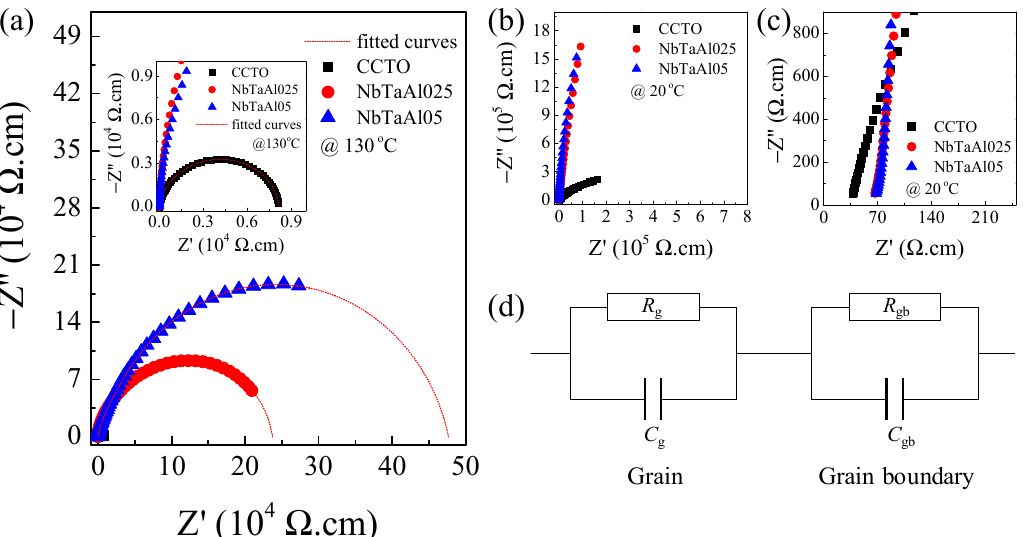
Figure 5. ( a ). Impedance complex Z* plots at 130 °C of the CCTO, NbTaAl025, and NbTaAl05 ceramics; its inset shows the enlarged scale of Z* plots at 130 °C. ( b , c ) the low- and high-frequency of Z* plot at 20 °C of these samples, respectively. ( d ) Equivalent circuit represented the electrical heterogeneous microstructure of semiconducting grain and insulating grain boundary.